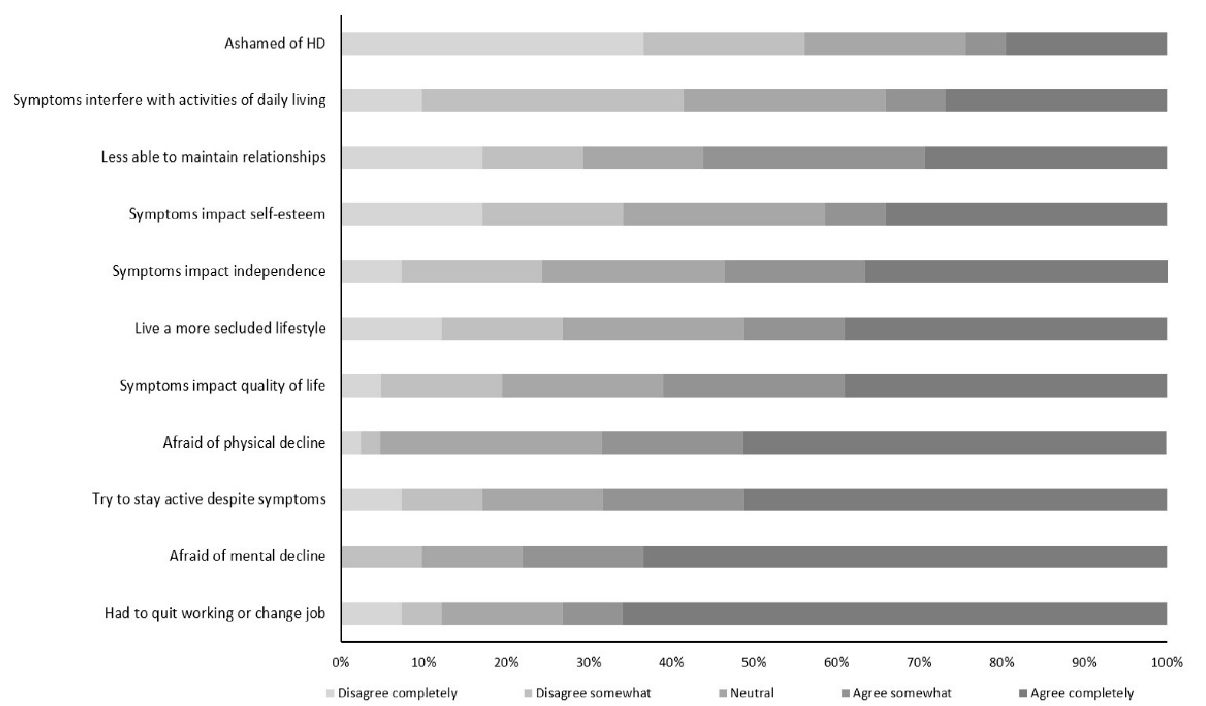
Figure 3. HRQoL outcomes of HD relative to GP. All comparisons adjusted for age and sex using propensity-score matching. Error bars indicate standard deviation. * p < 0.001. GP, general population; IHD, individuals with Huntington’s disease; CP, care partner; HRQoL, health-related quality of life. Likewise, PHQ-9 scores were significantly higher in IHD than GP, suggesting greater severity of depression (11.59 ± 7.20 vs. 5.85 ± 6.71; p < 0.001). Among care partners, HD- CP demonstrated significantly greater depression than GP-CP based on PHQ-9 scores (6.84 ± 6.38 vs. 4.15 ± 5.58; p < 0.001) but similar levels of HRQoL (EQ-5D and EQ-VAS, both NS). Notably, no significant differences were observed between HD and PD cohorts (both patients and care partners) on any of these measures (see Figure 4, all NS).